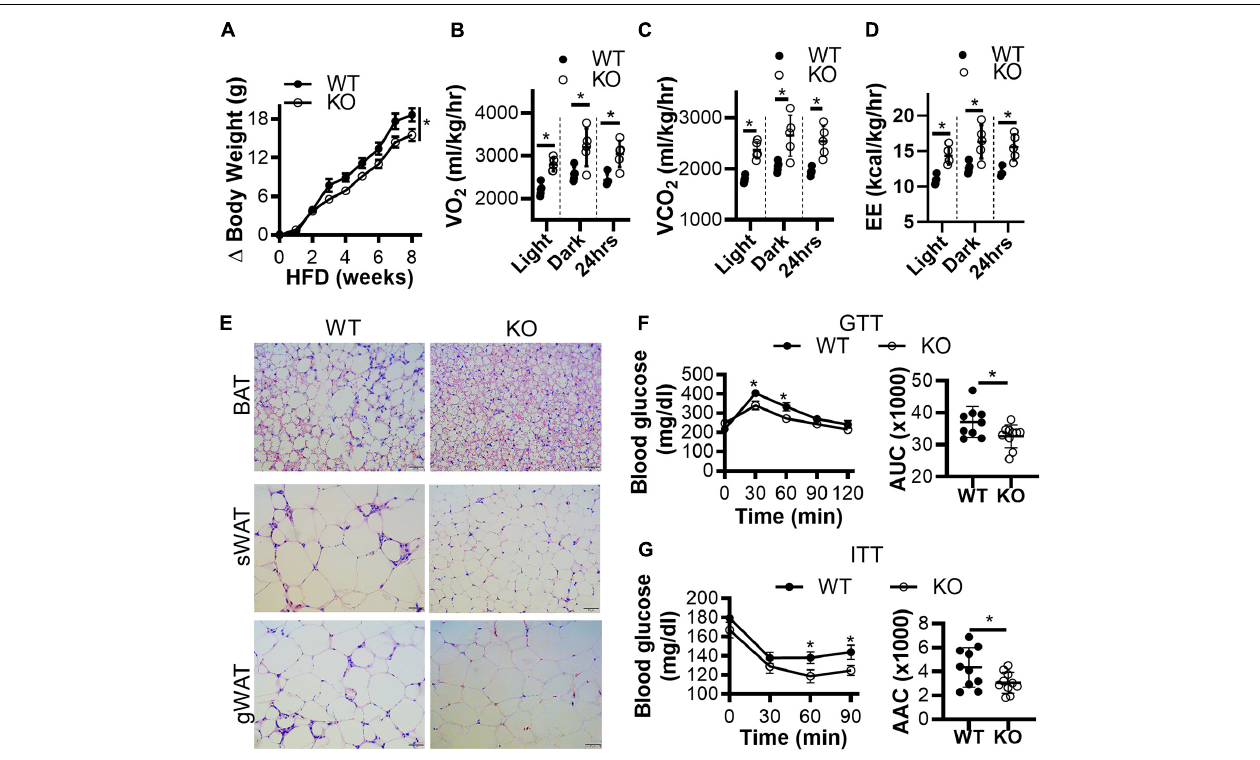
FIGURE 3 | Genetic knockout of CLK1 improves insulin sensitivity in mice. (A) The body weight gain of male CLK1 KO mice (KO) and wild-type littermate controls (WT) fed a high-fat diet (HFD) for 8 weeks, starting at 8 weeks of age and housed at regular room temperature at 22 ◦ C. n = 10 mice/group. Data shown as mean ± SEM. * p < 0.05 vs WT. (One-way ANOVA with Sidak’s multiple comparisons test). (B–D) The whole-body energy expenditure of CLK1 KO mice in panel (A) were measured at the end of the 8 weeks of HFD feeding. The environmental temperature in the metabolic chambers was set at 22 ◦ C. The metabolic index was monitored for 24 h, and the results were averaged during the light-on period, and during the light-off period, respectively. n = 5 mice/group. Data shown as mean ± SD. * p < 0.05 vs WT. (Unpaired Student’s t test). (E) H&E staining of BAT, sWAT, and gWAT at the end of the 8 weeks of HFD feeding in panel (A) , scale bar, 100 µ m. (F) The glucose tolerance test (GTT) and (G) the insulin tolerance test (ITT); the histograms show the corresponding areas under the curves (AUC) for GTT, and areas above the curves (AAC) for ITT. n = 10 mice/group. Data shown as mean ± SEM. (One-way ANOVA with Sidak’s multiple comparisons